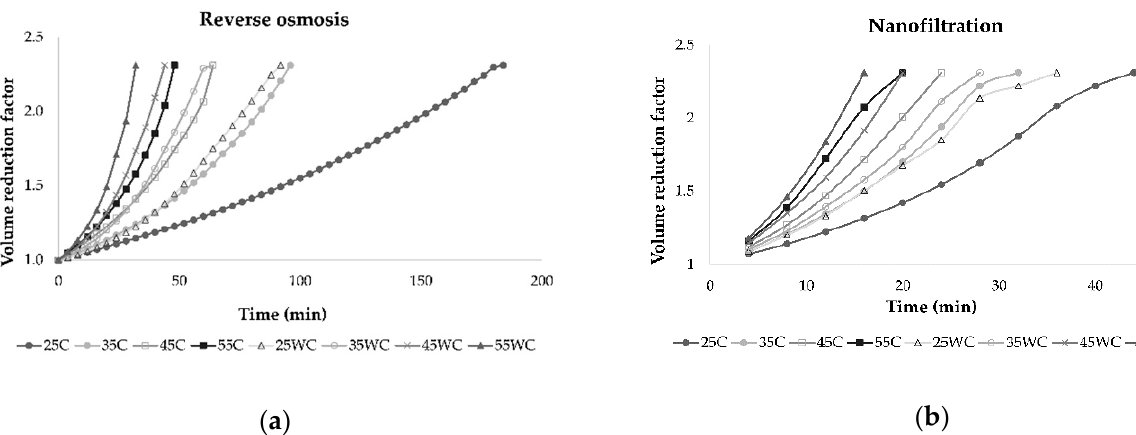
Figure 3. Influence of process duration (min) on volume reduction factor during concentration of Cabernet Sauvignon red wine by reverse osmosis ( a ) and nanofiltration ( b ) at 25, 35, 45, and 55 bar, with (C) and without cooling (WC).